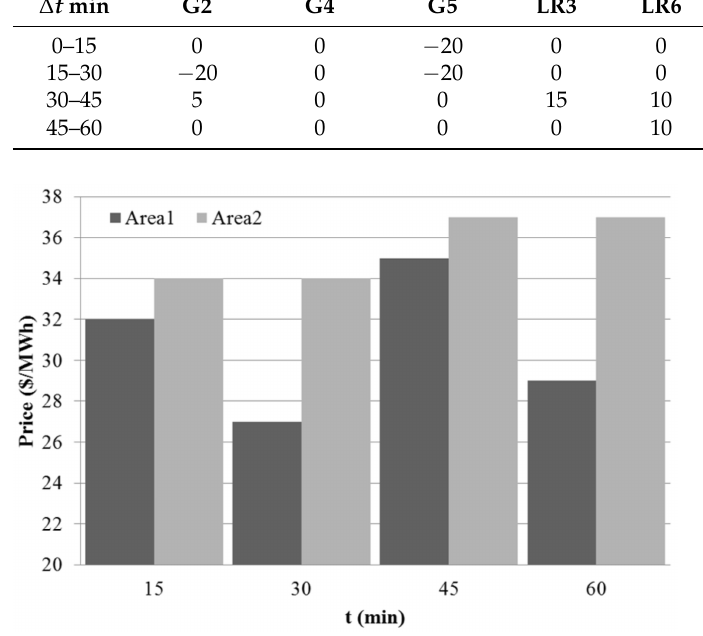
Figure 4. Balancing prices in Area1 (n1, n2, n3) and Area2 (n4, n4,